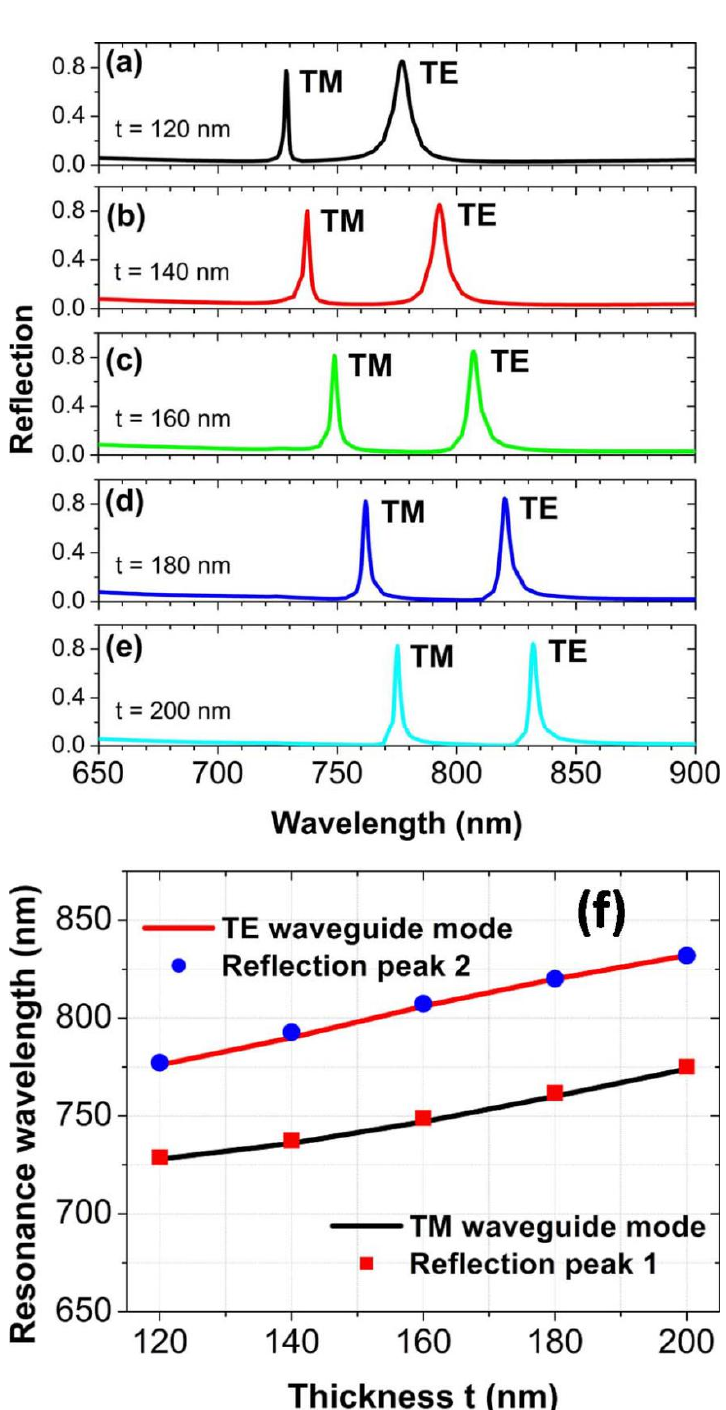
Figure 5. ( a – e ) The reflection spectra at normal incidence for di ff erent thicknesses of ITO film. ( f ) Compare the positions of reflection peaks with the resonance wavelengths of waveguide modes.